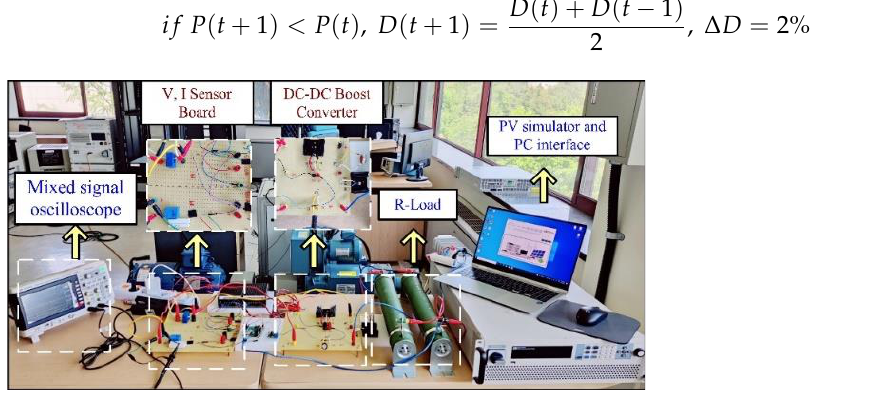
Figure 10. Hardware prototype model.